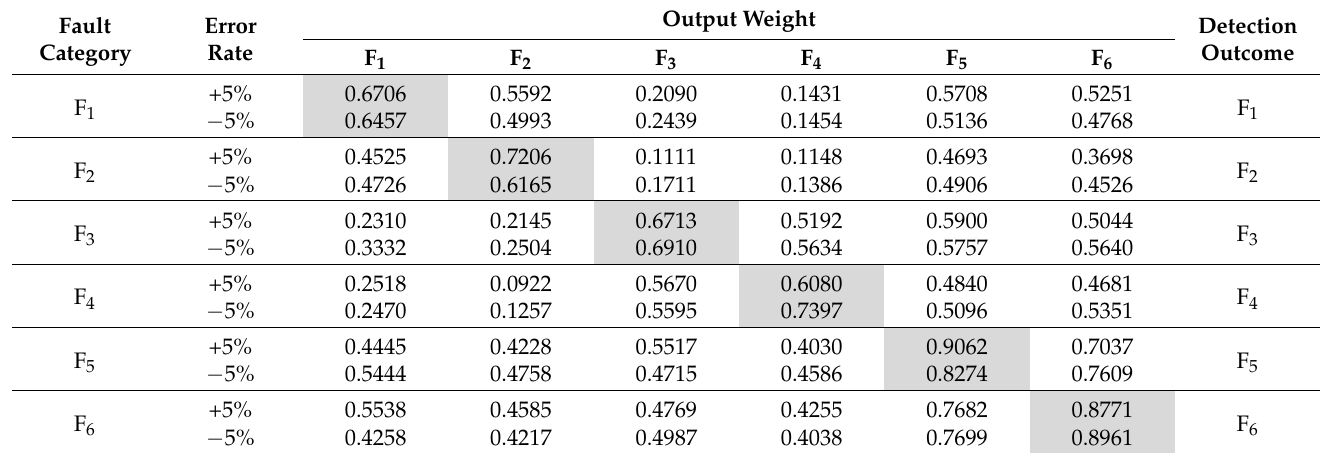
Table 8. Detection outcomes of the inverter at 52 Hz with a ± 5% error margin.